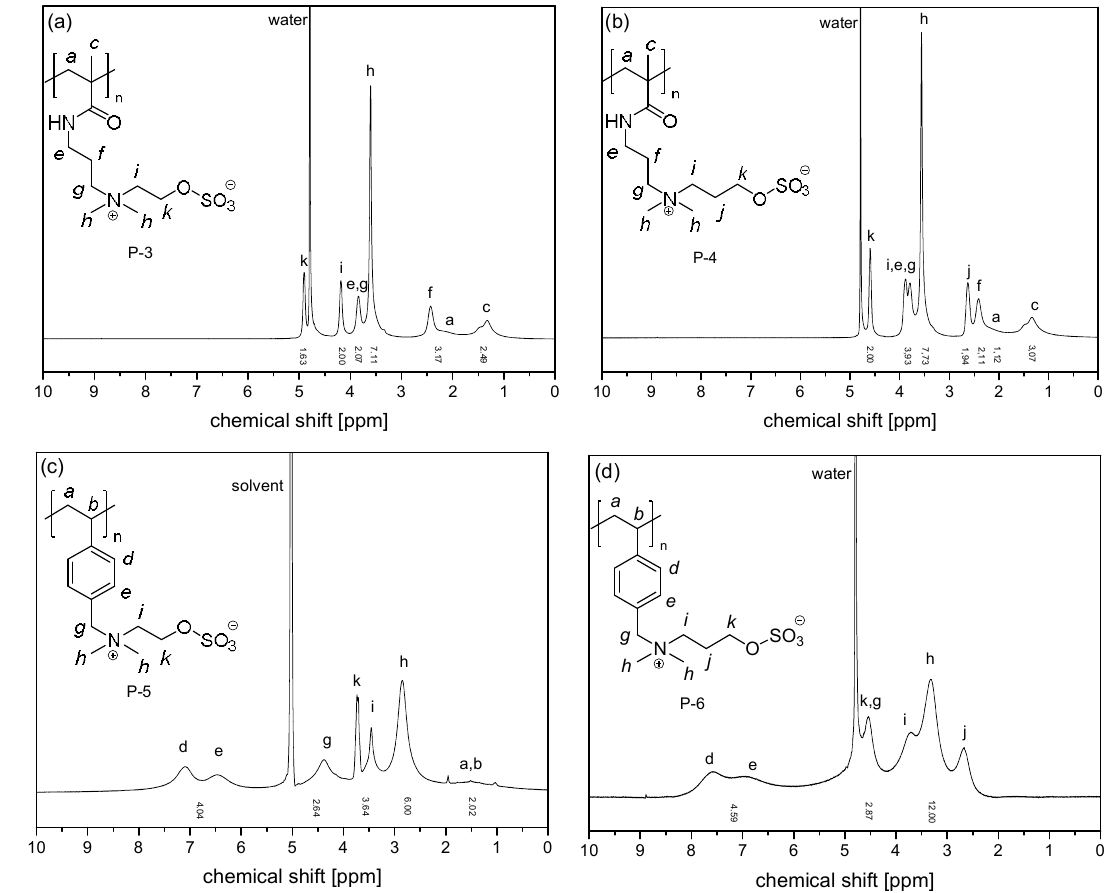
Figure 3. 1 H NMR spectra of ( a ) P-3 in D 2 O saturated with NaCl, ( b ) P-4 in D 2 O saturated with NaCl, ( c ) P-5 in TFE-d 3 , ( d ) P-6 in D 2 O saturated with NaCl.